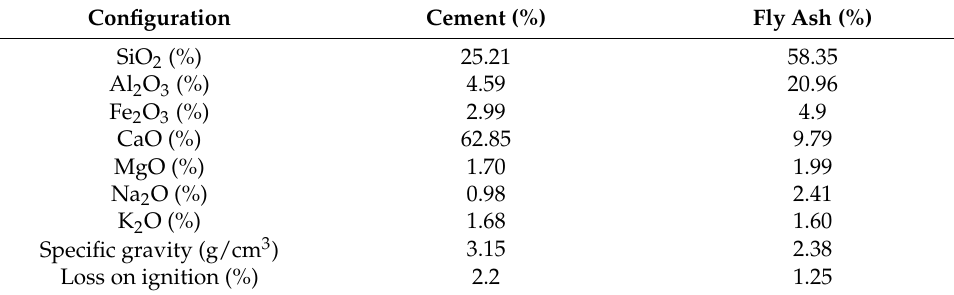
Figure 1. Gradation curves for fine aggregates and crumb rubber. Table 1. Chemical composition of cementitious materials.